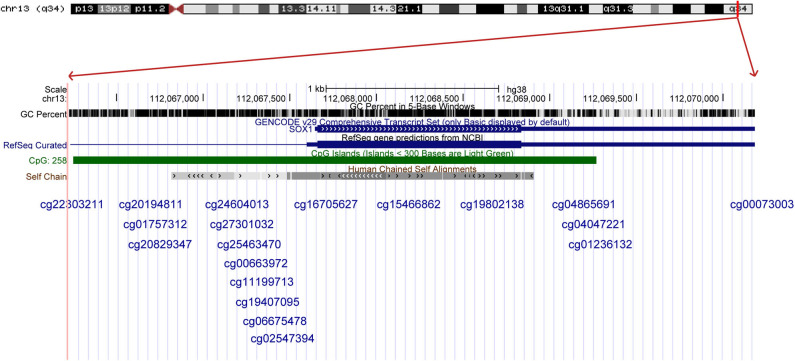
The location of all the CpG island probes in the SOX1.